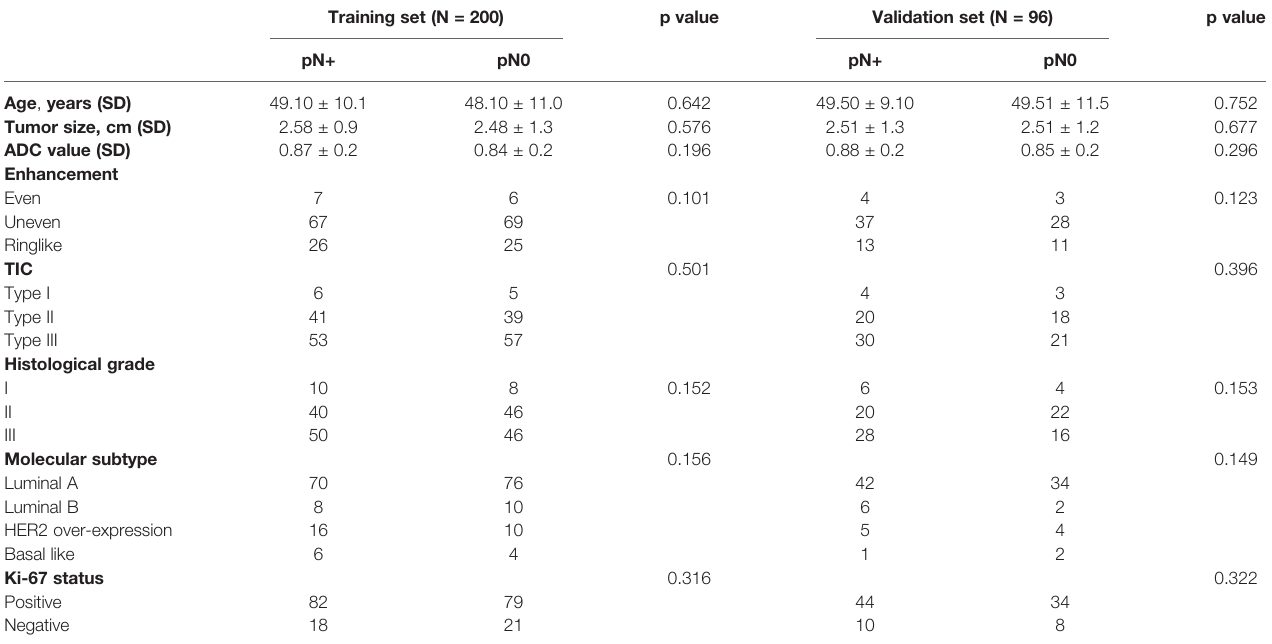
TABLE 1 | Patient characteristics in the training and validation